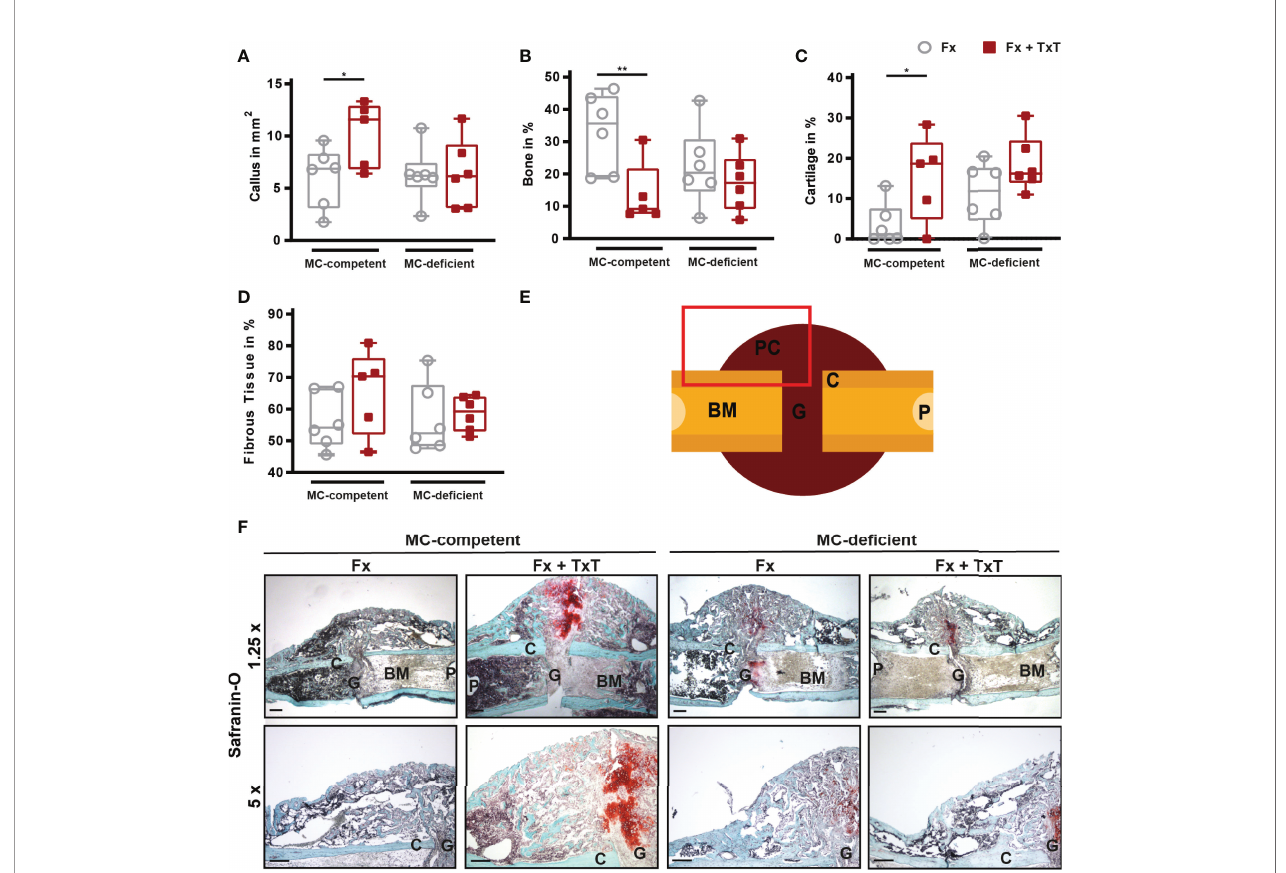
FIGURE 7 | Histomorphometrical analysis from fractured femurs of mast cell (MC)-competent and MC-de fi cient mice 21 d after isolated fracture (Fx) and combined fracture and thoracic trauma (Fx + TxT). Sections of fractured femurs were stained with Safranin O and (A) callus size, (B) relative bone area, (C) relative cartilage area, and (D) relative fi brous tissue area were determined by histomorphometric analysis. (E) Schematic illustration of the area (red rectangle) of the fracture callus that was illustrated in F bottom. C = cortex, G = gap, P = pin hole, PC = periosteal callus, BM = bone marrow. (F) Representative images from the periosteal fracture callus stained with Safranin O in 1.25 x (top) and 5 x (bottom). Scale bar (top) = 500 µm; scale bar (bottom) = 200 µm. Gray boxes represent Fx mice, red boxes represent Fx + TxT mice. Data are shown as box-and-whisker plots (with median and interquartile range) from maximum to minimum, showing all data points. *p<0.05; **p<0.01. The p values were determined using one-way ANOVA with post-hoc Fisher ’ s